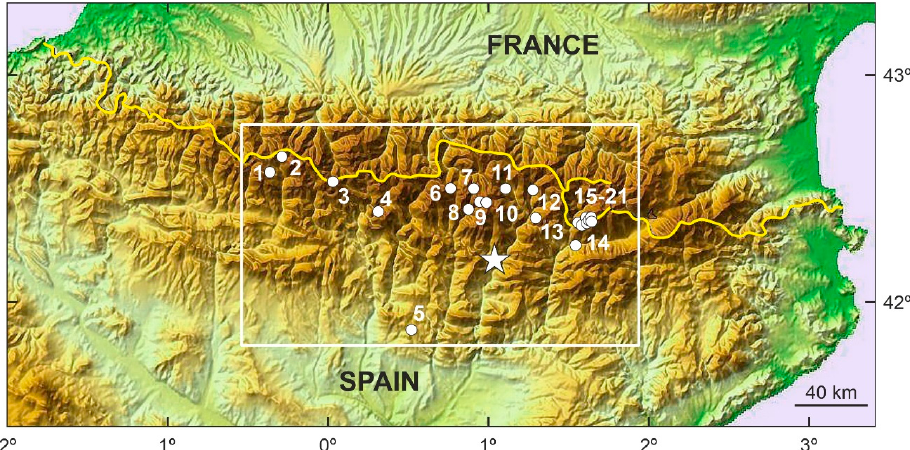
Figure 2. Topographic map of the Pyrenean range, which marks the boundary between Spain and France (yellow line), indicating the location of Lake Montcortès (white star) within the central Pyr- enees (white box) and the approximate location of sites with palynological records (white dots) used for comparison. Localities: 1, Ibón de las Ranas; 2, Tramacastilla; 3, Marboré; 4, Bassa de la Mora; 5, Estanya; 6, Redon; 7, Bassa Nera; 8, Llebreta; 9, Redó; 10, Sant Maurici; 11, Prats de Vila; 12, Esta- nilles; 13, Coma de Burg; 14, Pradell; 15, Serra Mitjana; 16, Planells de Perafita; 17, Riu dels Orris; 18, Estany Blau; 19, Forcat; 20, Orris de Seut; 21, Bosc dels Estanyons (details in Refs. [16,18]). Forests 2023 , 14 , x FOR PEER REVIEW